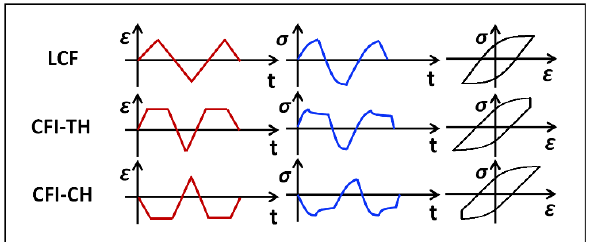
Figure 1. Schematic waveforms used for LCF and CFI tests with tensile hold (CFI-TH) or compressive hold (CFI-CH).